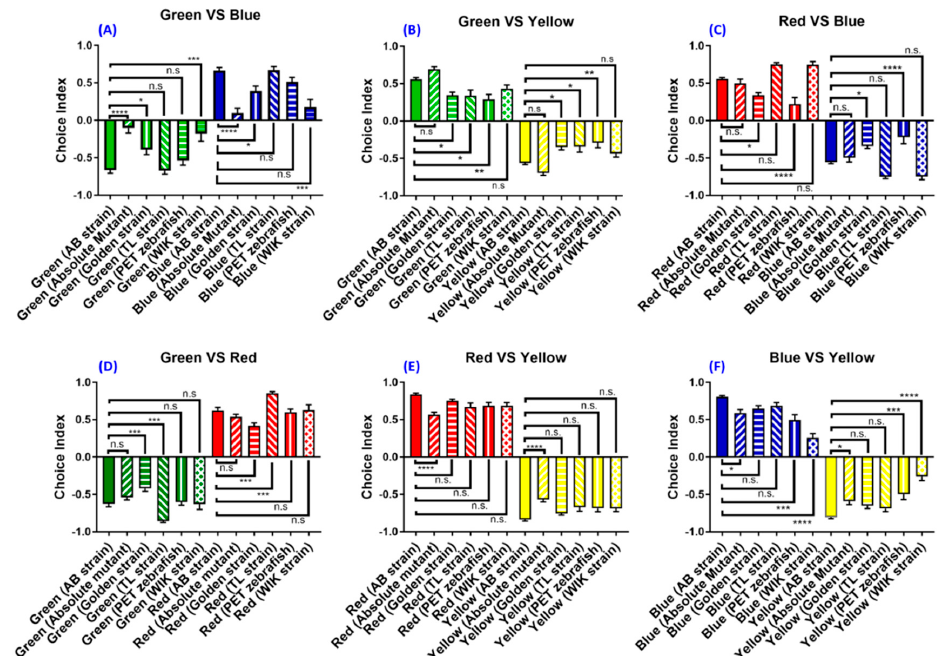
Figure 6. Color preference ranking and index di ff erence between six di ff erent zebrafish strains. The color preference index for the ( A ) green vs. blue, ( B ) green vs. yellow, ( C ) red vs. blue, ( D ) green vs. red, ( E ) red vs. yellow, ( F ) and blue vs. yellow combinations. The data are presented as mean ± SEM, n = 24 for each strain, except for the Wild Indian Karyotype (WIK) strain ( n = 12). The di ff erence was tested by one-way ANOVA and the significance level was set at * p < 0.05, ** p < 0.01, *** p < 0.001, **** p < 0.0001. n.s. = non-significant.